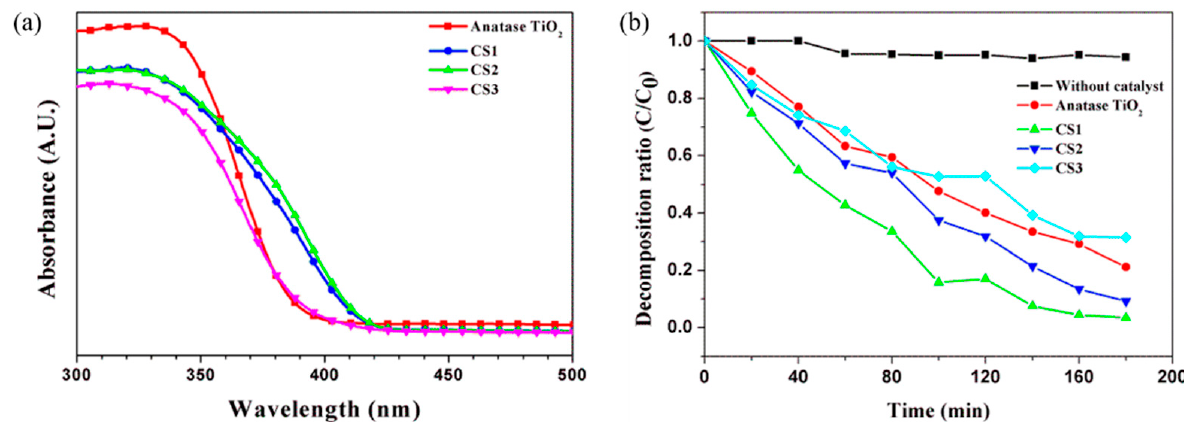
Figure 8. ( a ) UV–vis absorption spectrum and ( b ) photocatalytic methyl orange degradation of synthesized hollow particles (calcination temperature: 700 °C) under UV light irradiation time.